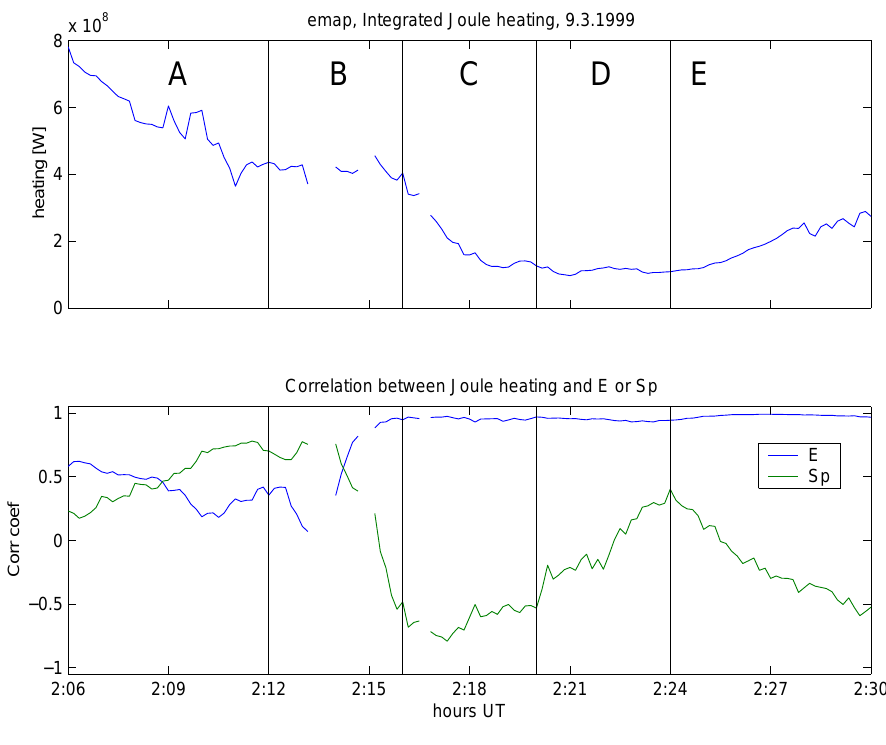
Fig. 14. Time series of the Joule heating (upper panel) and its correlation with the electric field and Pedersen conductance (lower panel). Correlation is calculated over the emap data area, separately for each time step. The different regions (A–E) of the omega-band are labelled as in Fig. 12.